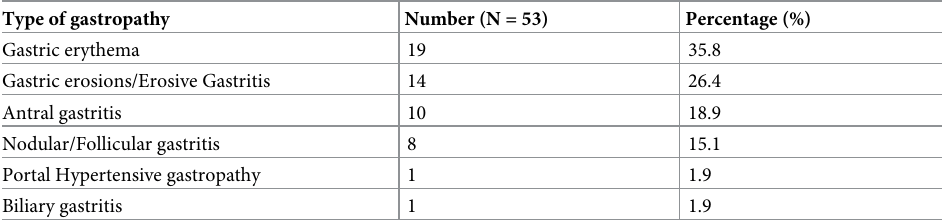
Table 4. Gastropathies seen in the study